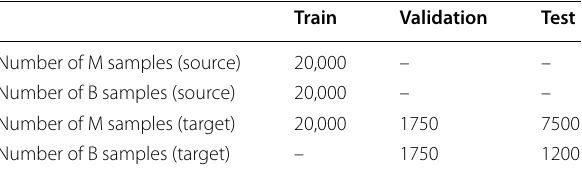
Table 2 Number of data samples used during training, validation and